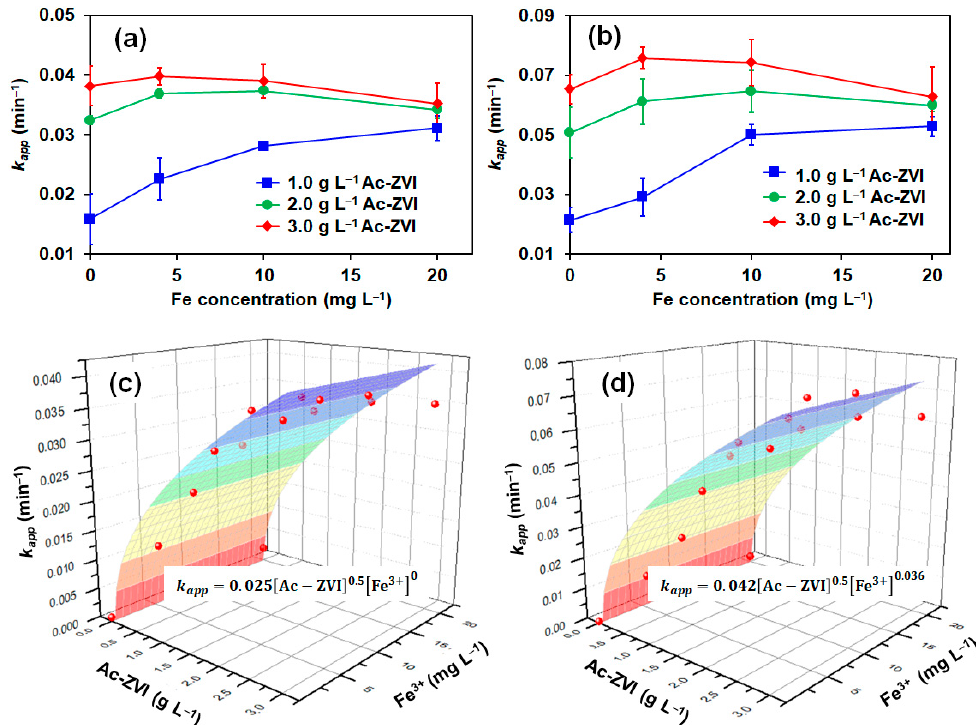
Figure 1. Effect of the Fe 3+ :Ac-ZVI ratio on the AO7 removal rate for ( a ) PMS and ( b ) PDS systems, and the relationship of k app , Ac-ZVI dosage and Fe 3+ in the ( c ) PMS and ( d ) PDS systems. Conditions: [AO7] = 8.5 mg L − 1 and pH = 3–4.